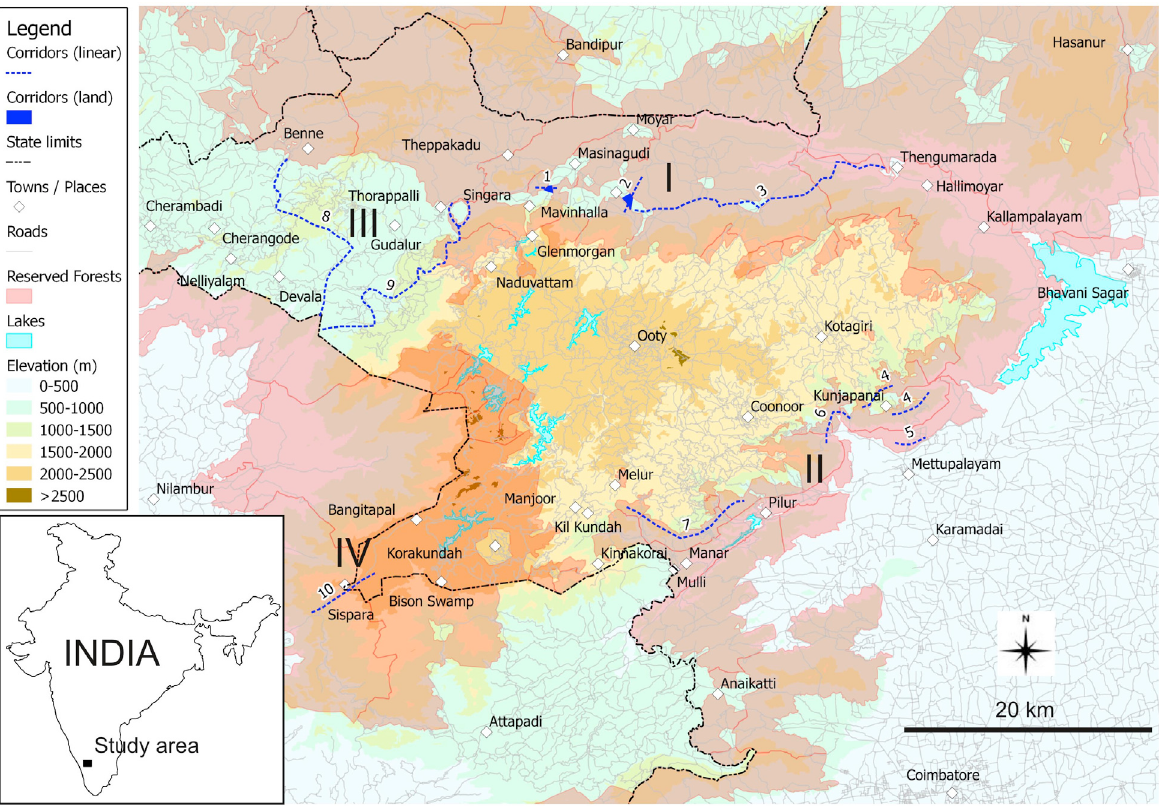
Image 1. Study area with the 10 reported corridors (see text for details) and the four regions in which ecosystem connectivity was severed or under threat: (I) the northern slopes and the southern portion of the Deccan Plateau, (II) the south and south-eastern slopes, (III) the Gudalur plateau, and (IV) the upper